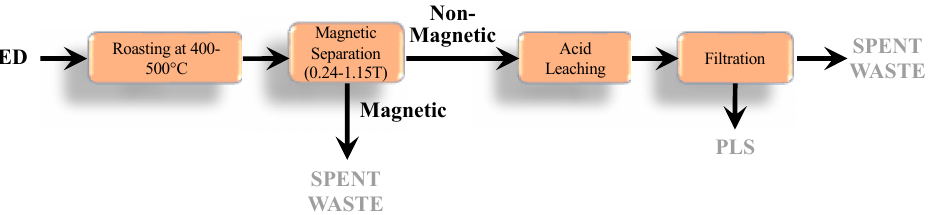
Figure 3. A general process diagram of the sample calcination, magnetic separation and acid leaching tested in this investigation.